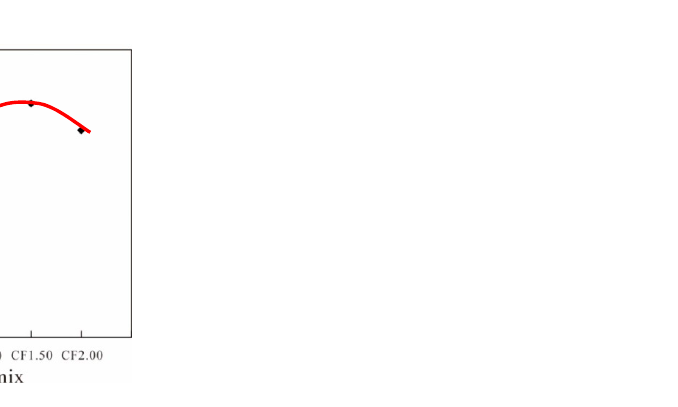
Figure 4. Effect of carbon fiber content on the compressive strength. CF, carbon fiber; PC, plain concrete.